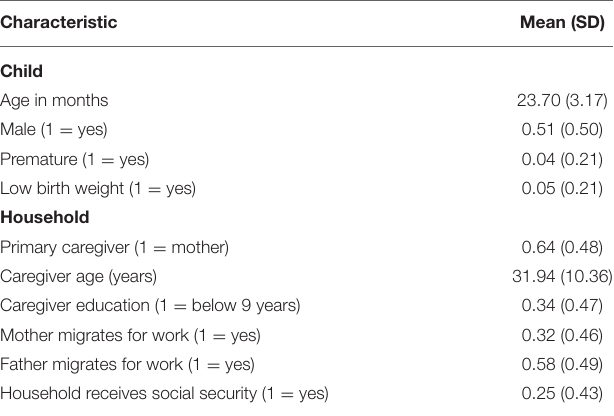
TABLE 1 | Characteristics of child and household (18–30 months) ( N =